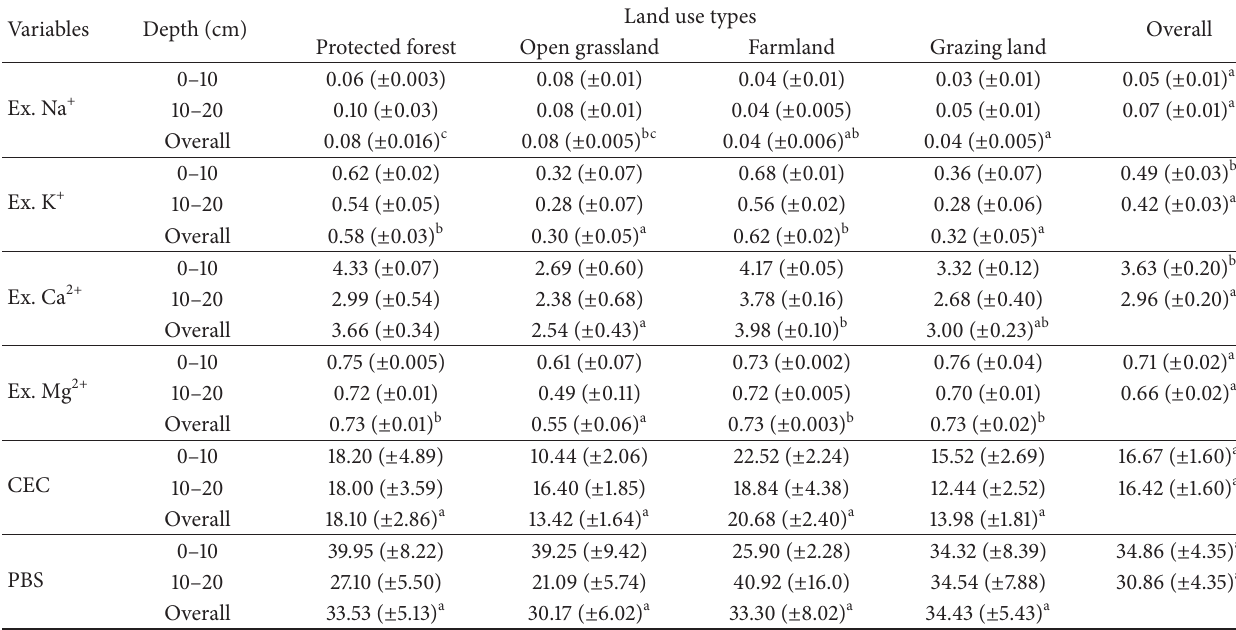
Table 5: Exchangeable cations (cmol (+)/kg soil), cation exchange capacity (cmol (+)/kg soil), and percent base saturation (%) in relation to land use and soil depths (mean ± S.E).